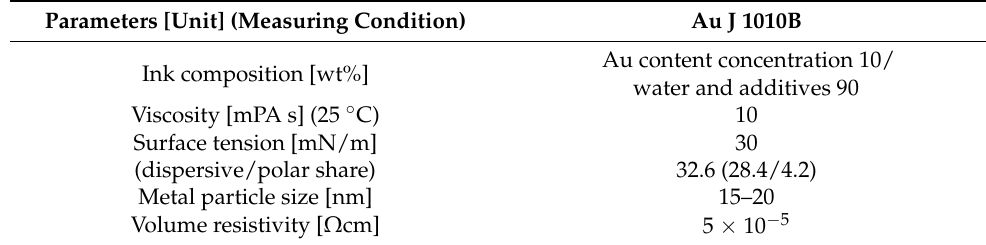
Formulation and properties of Drycure Au J 1010B (C-INK CO, Ltd., Soja City,